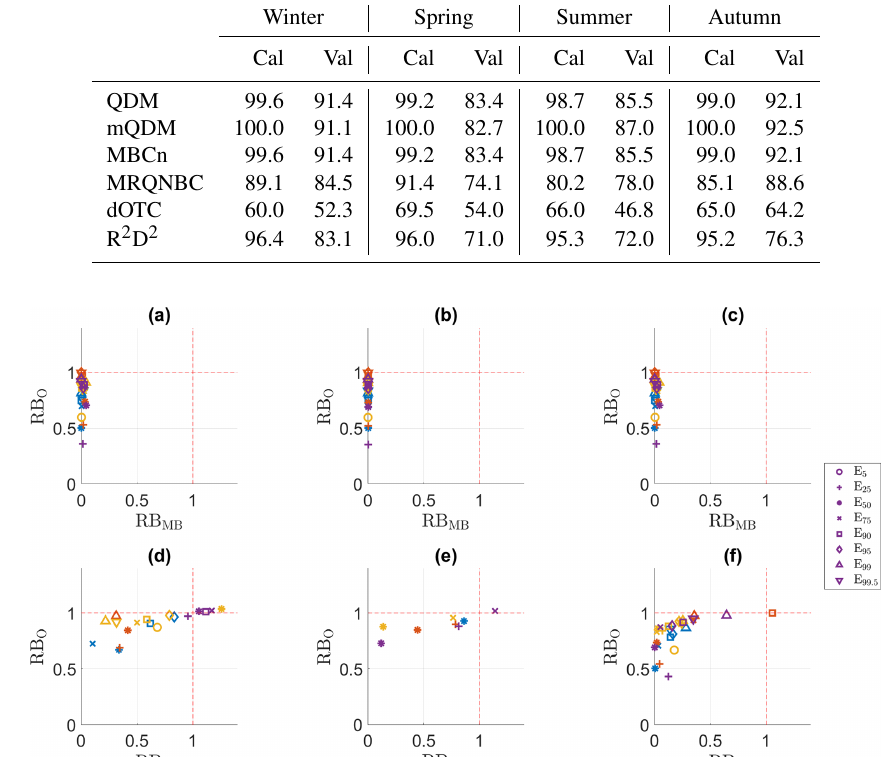
Table 7. PSS values for evaporation in the calibration (Cal) and validation (Val) periods (%). Winter Spring